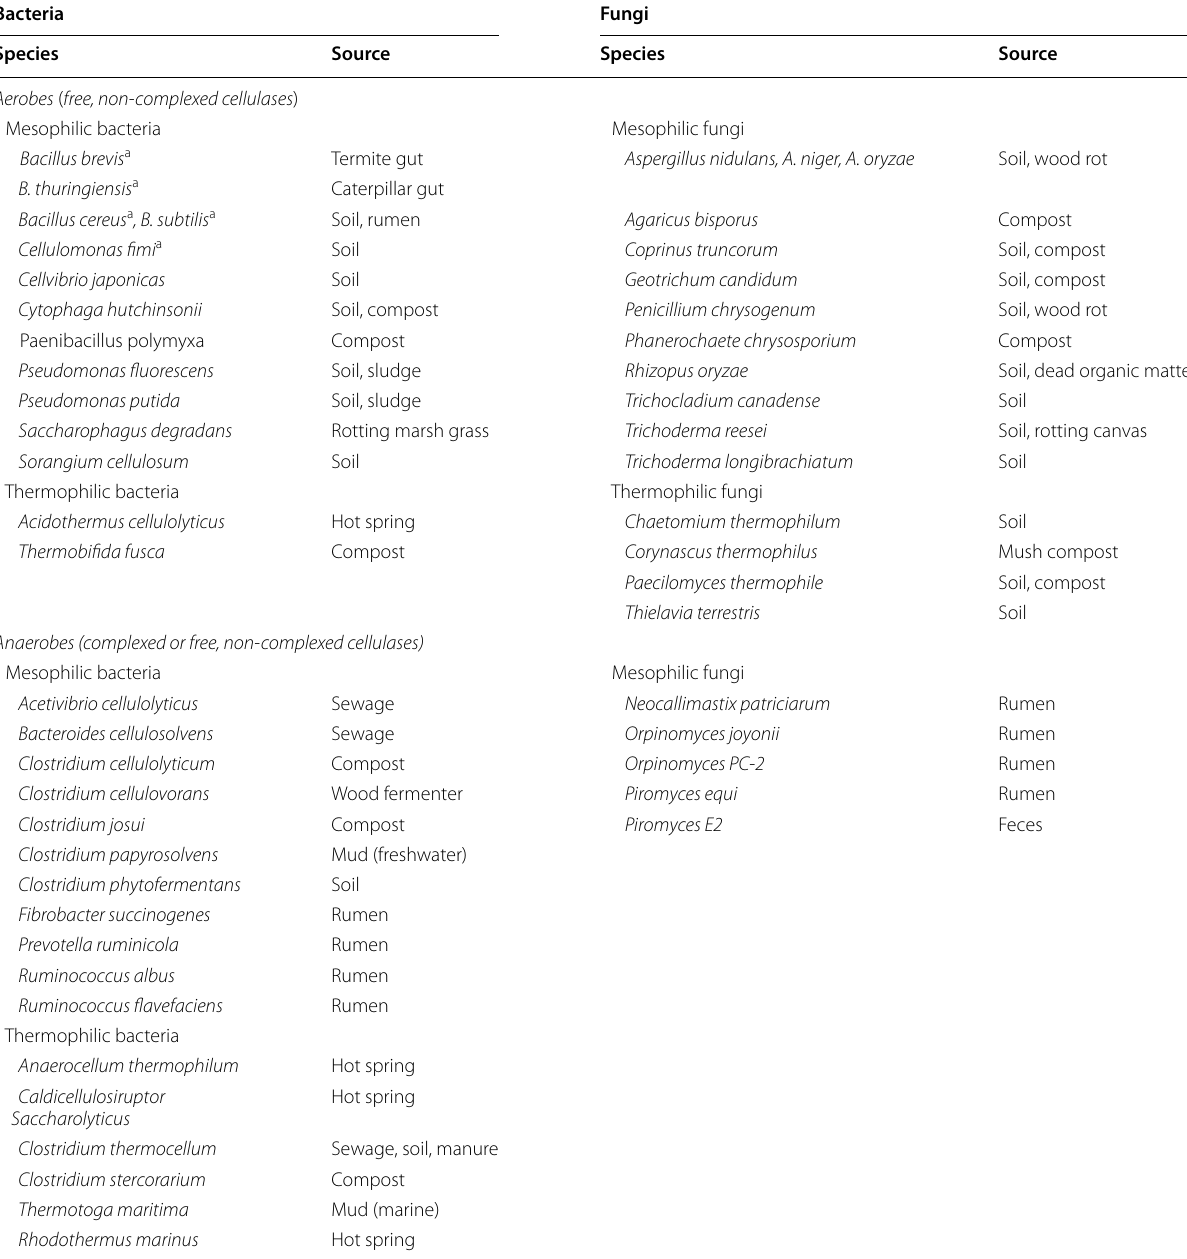
a Most Cellulomonas and Bacillus strains are facultative anaerobes that can also grow anaerobically